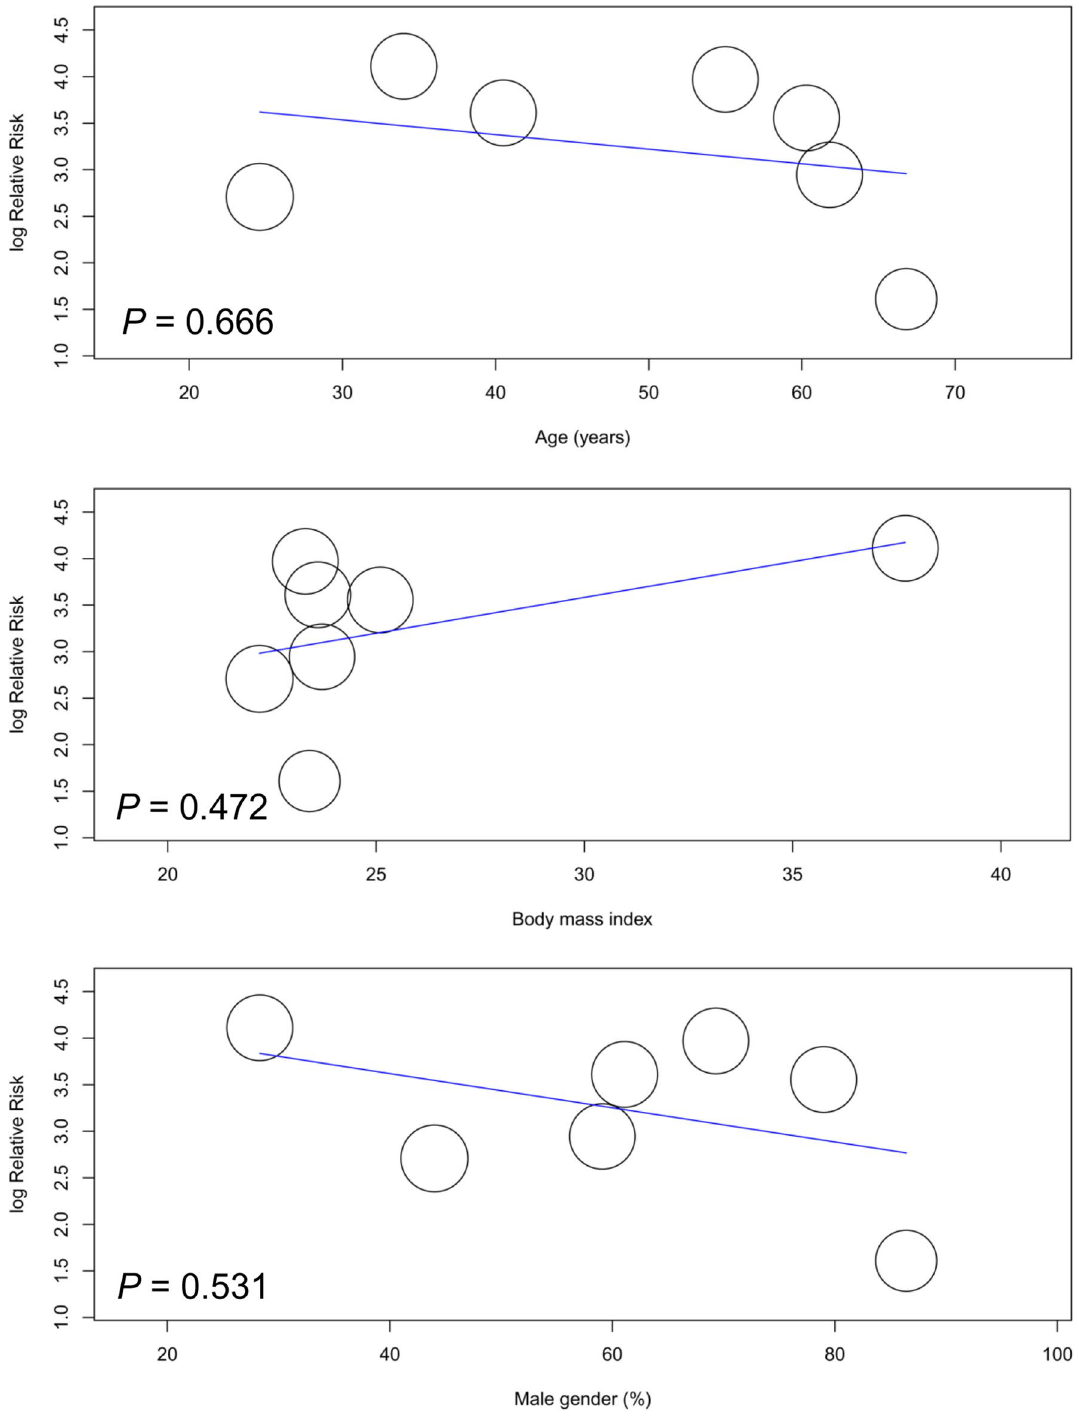
Figure 3. Meta-regression plot showing the association of patient characteristics (i.e., age, prevalence of male gender, and body mass index) with the risk of high cuff